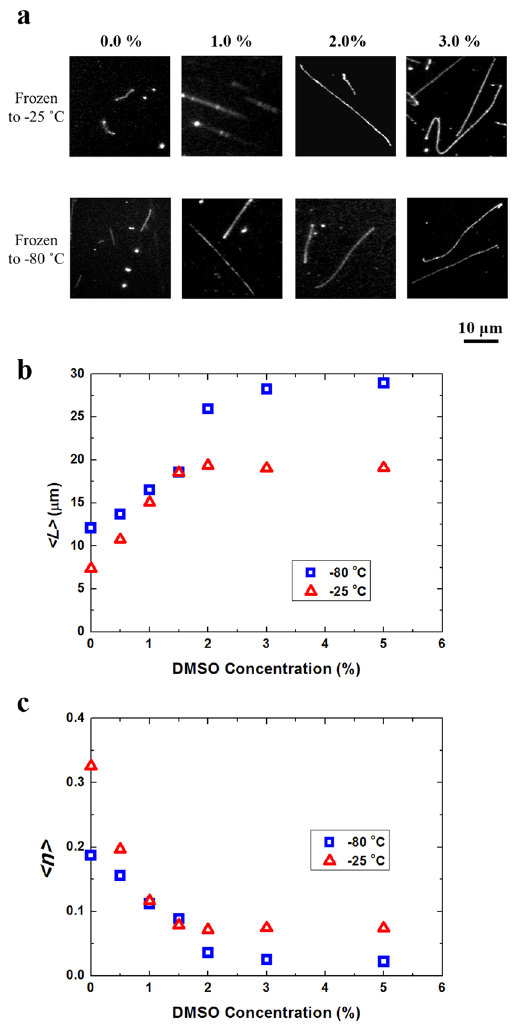
Figure 4. Freezing-induced DSBs. ( a ) Single DNA image after freeze/thawing to − 25 °C (upper: slow frozen) and − 80 °C (lower: quick frozen). ( b ) Average lengths of DNA, 〈 L 〉 , vs. the concentration of DMSO. ( c ) The number of DSBs per 10 kbp, 〈 n f 〉 , vs. the concentration of